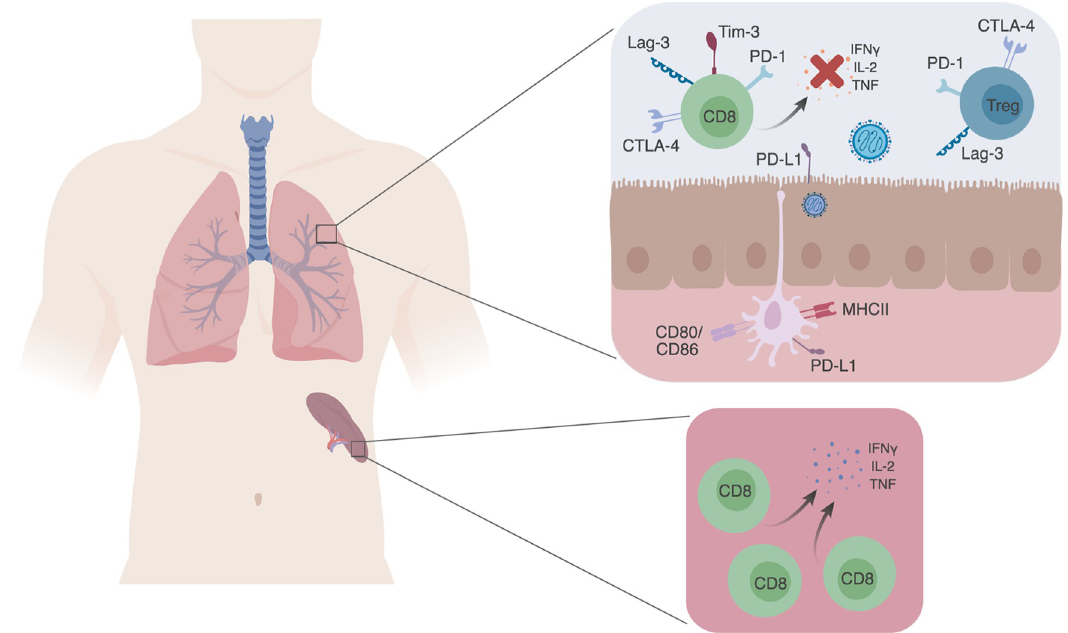
Fig 1. Respiratory virus infection is associated with T-cell impairment. During respiratory virus infection, impaired virus-specific T cells in the lung fail to produce pro-inflammatory cytokines or perform cytotoxic functions. T-cell impairment is at least partially mediated by expression of inhibitory receptors, which decrease effector T-cell function and promote Treg activity. In contrast, virus- specific T cells in the spleen rarely express inhibitory receptors and are functional. PD-1 and other inhibitory receptors are expressed in the lung during both primary infection and reinfection. CD8, cluster of differentiation 8; CTLA-4, cytotoxic T-lymphocyte- associated protein 4; IFN Ɣ , interferon gamma; IL-2, interleukin 2; Lag-3, Lymphocyte-activation gene 3; MHCII, major histocompatibility complex class II; PD-1, programmed cell death 1; PD-L1,; Tim-3, T-cell immunoglobulin and mucin-domain containing-3; TNF, tumor necrosis factor; Treg, regulatory T